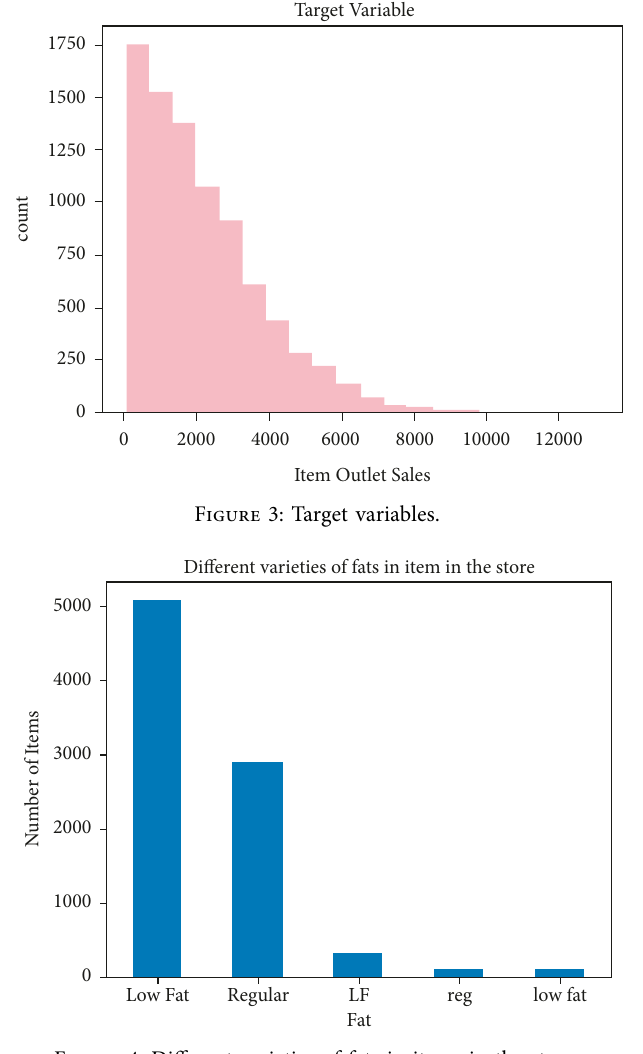
Figure 3: Target variables.